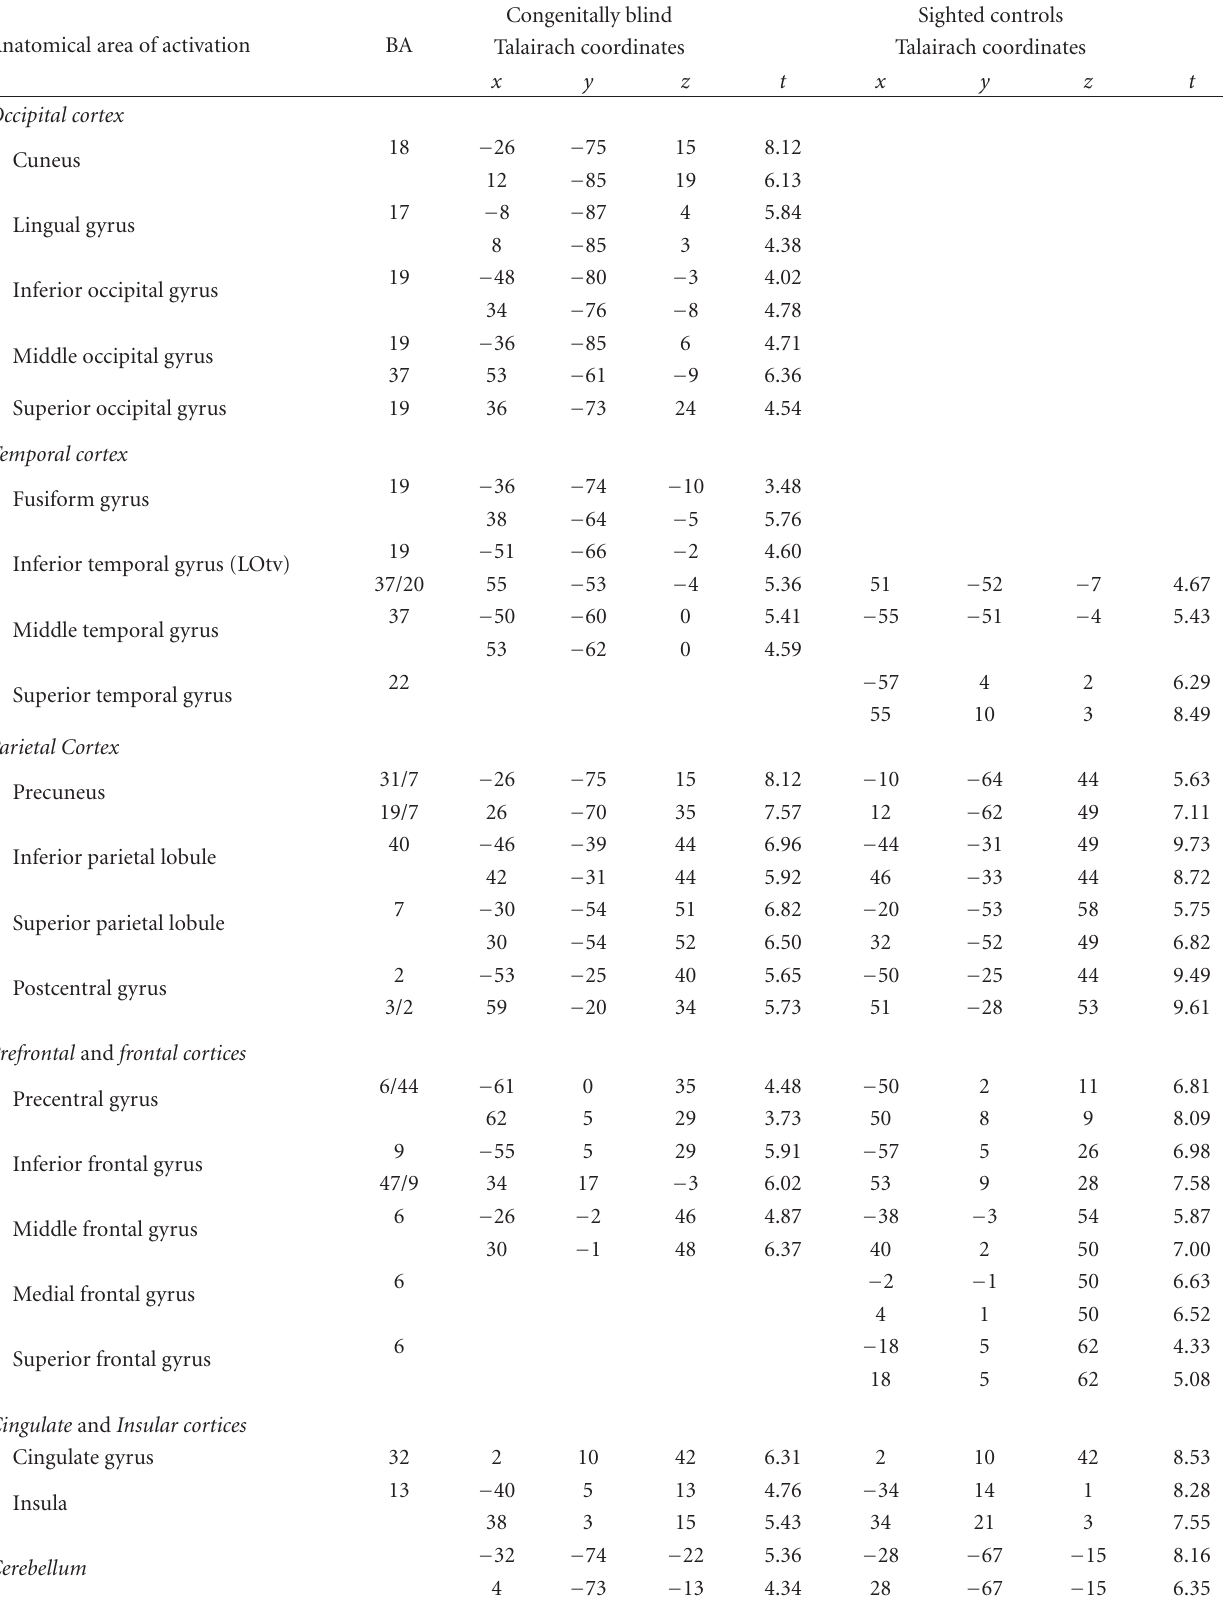
Table 1: Activation clusters for “shapes versus rest” in blind and sighted